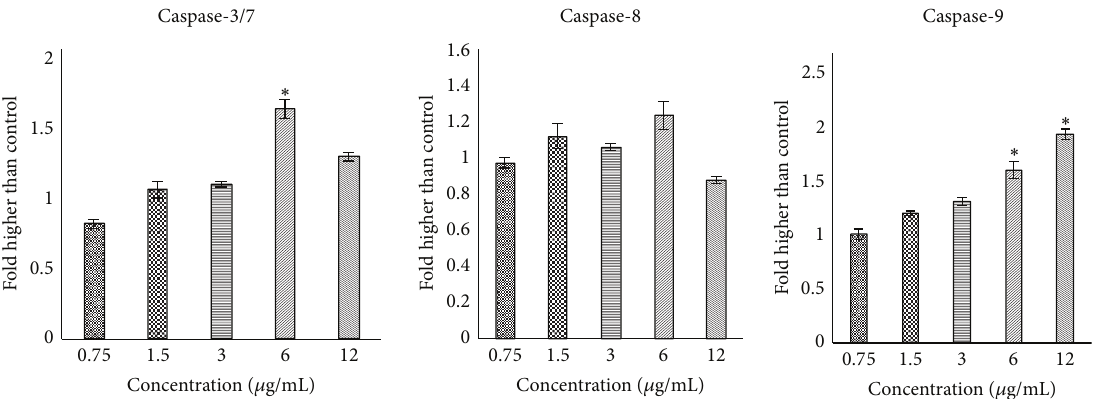
Figure 8: Relative luminescence expression of caspases 3/7, 8, and 9 in HT-29 cells treated with various concentrations of Cu(BrHAP) 2